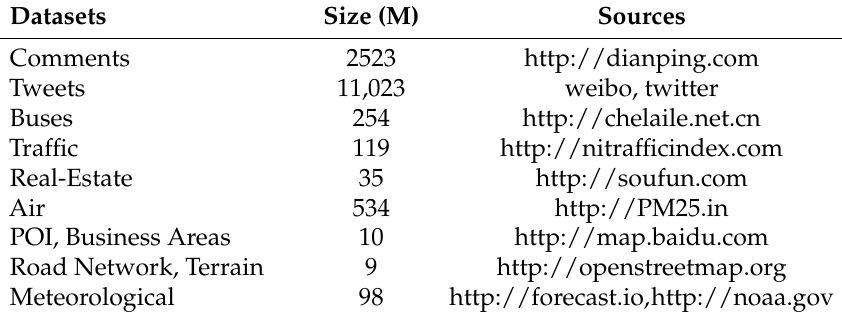
Table 1. Details of the